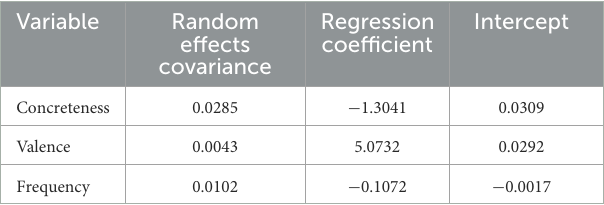
TABLE 2 Results of directionality inference from generalized linear mixed modeling with language as a random